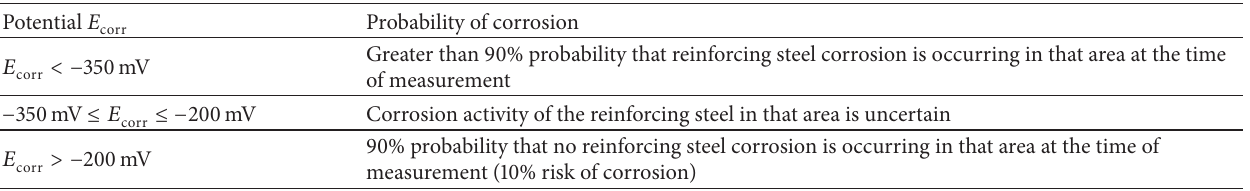
Figure 1: Existing corrosion methods: (a) half-cell potential measurement [27] and (b) concrete resistivity measurement [28]. Table 1: Dependence between potential and corrosion probability [8].